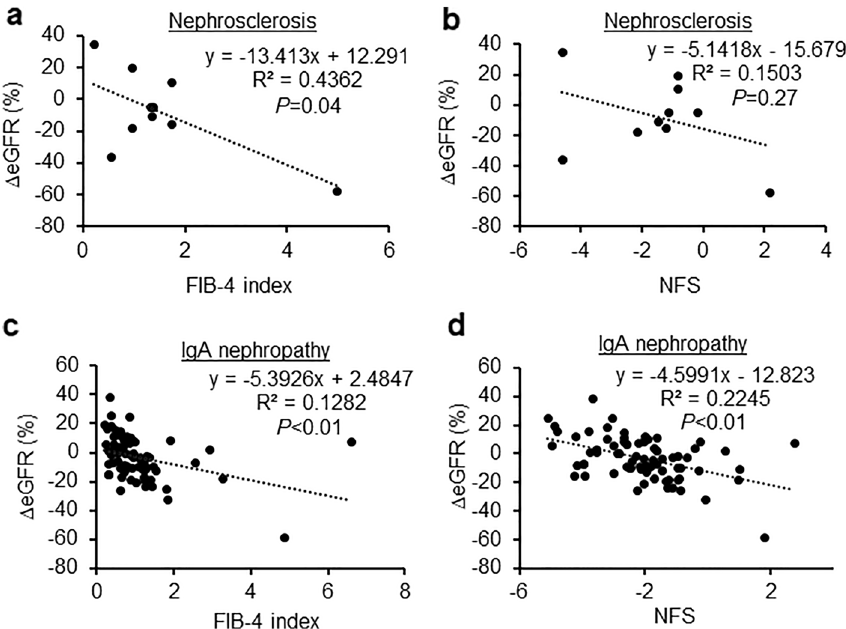
Figure 2. Associations between the change in estimated glomerular filtration rate and fibrosis markers in nephrosclerosis and IgA nephropathy. ( a , b ) Correlation between the change in the estimated glomerular filtration rate and the FIB-4 index ( a ) and NFS ( b ) in nephrosclerosis. ( c , d ) Correlation between the change in the estimated glomerular filtration rate and the FIB-4 index ( c ) and NFS ( d ) in IgA